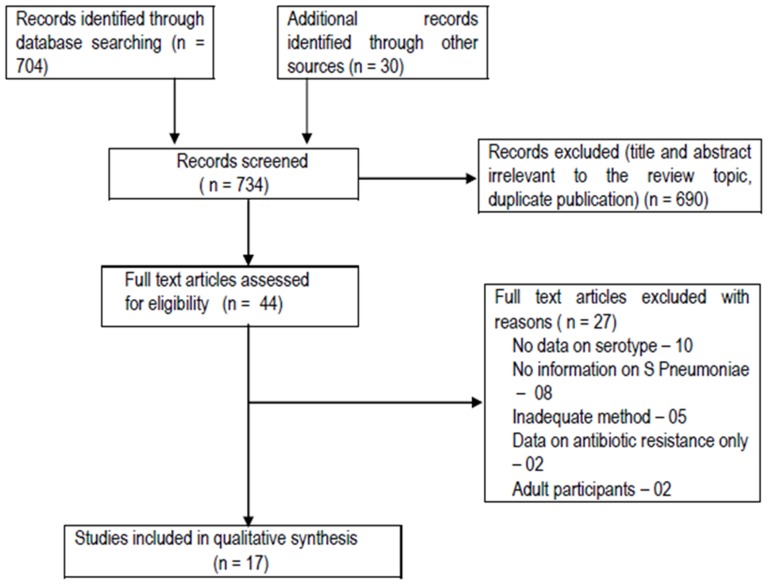
Flow of study in the review.